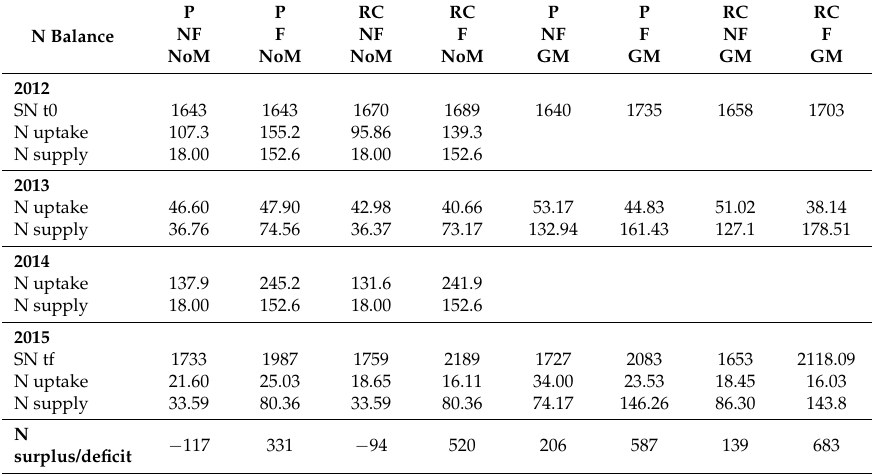
Table 5. Soil N surplus/deficit (kg N ha − 1 ) for the whole field experiment divided by treatment combinations (in columns): tillage system, organic amendment, and green manuring (P: conventional plough; RC: reduced chisel; F: composted farmyard manure; NF: unfertilized control; GM: green manure; NoM: no green manure). SN = soil nitrogen at to (2011) and tf (2015); N uptake (N content × dry biomass); N supply (N fertilizer + N fixed green manure + N fixed cash crop + N deposition). The parameters (SN, N uptake, and N supply) in each cropping season (2012 spelt, 2013 chickpea,